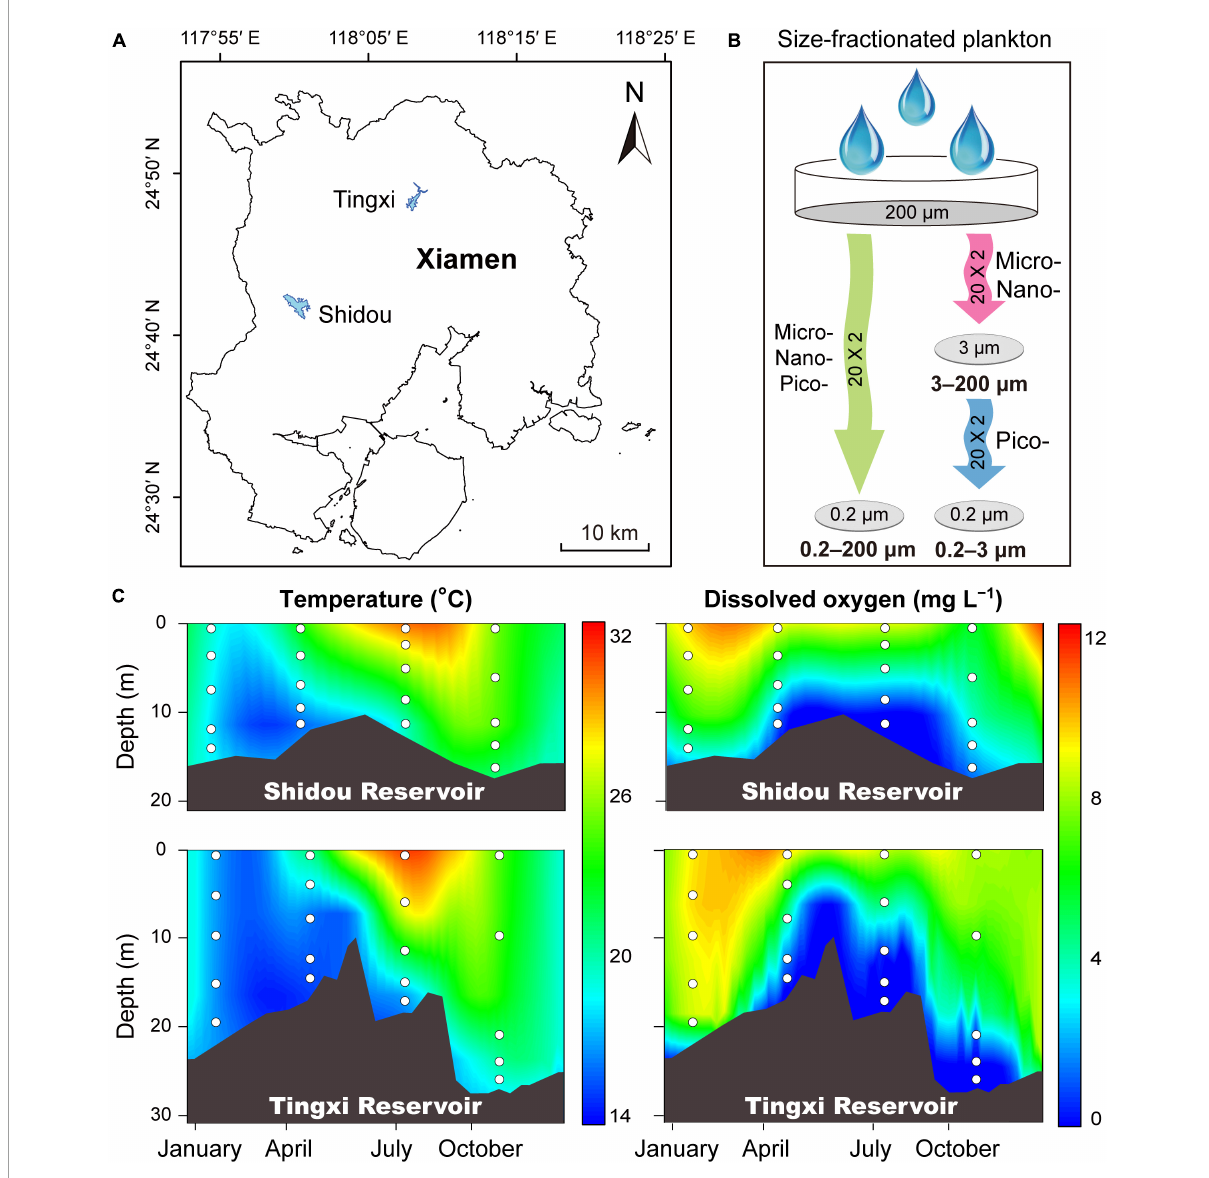
FIGURE1 Sampling sites of the Shidou and Tingxi reservoirs in Xiamen city (A) , and size-fractionated filtering strategies (B) . Micro-, nano-, and pico-eukaryotic plankton: 0.2–200 µ m; Micro- and nano-eukaryotic plankton: 3–200 µ m; Pico-eukaryotic plankton: 0.2–3 µ m. Depth-time profiles of water temperature and dissolved oxygen in the Shidou and Tingxi reservoirs, respectively (C) . White dots indicate the sampling